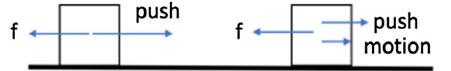
FIG. 9. Our interpretation of student reasoning that it takes less force to keep the furniture moving because it “ has a force of momentum on it ” that “ assist[s] ” the